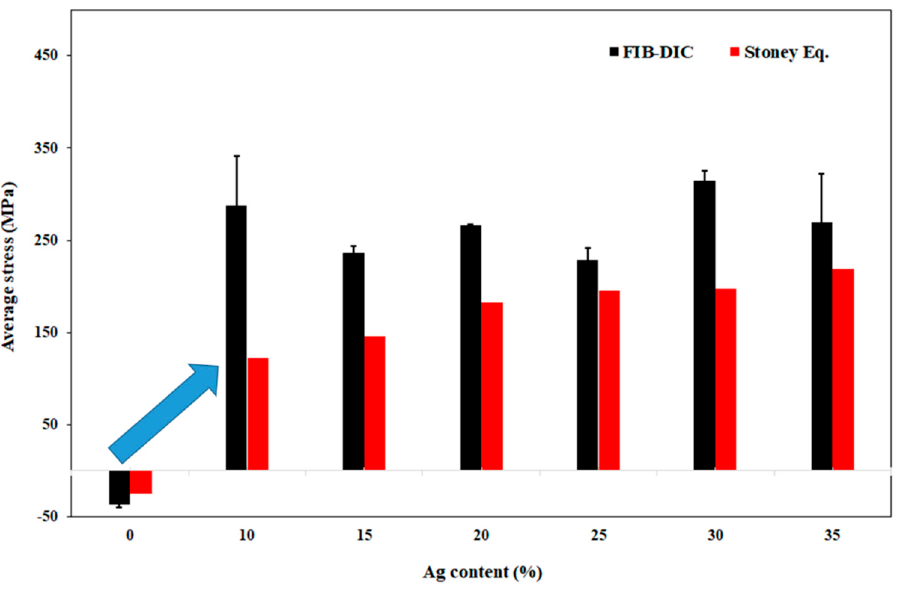
Figure 10. Average residual stress determined by the FIB-DIC method and from the substrate curvature measurements according to the Stoney’s equation as a function of the Ag content in the Ti-Cu-Ag thin films.